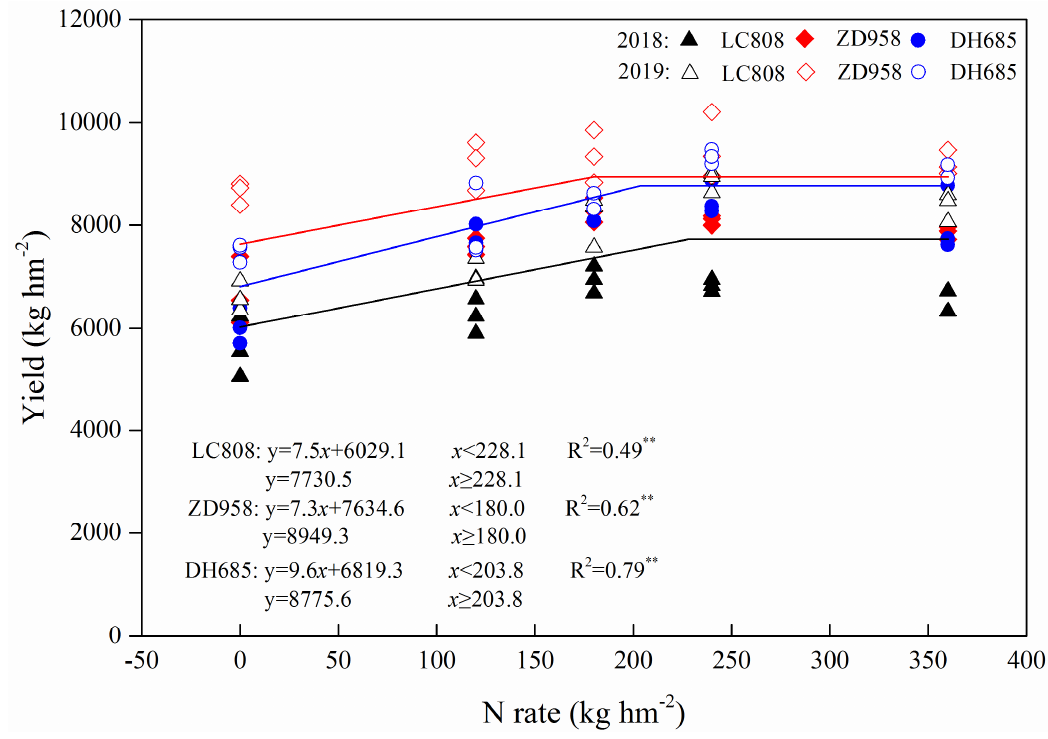
Figure 6. Regression equation between N fertilizer rates and yields for different types of stay-green maize. green